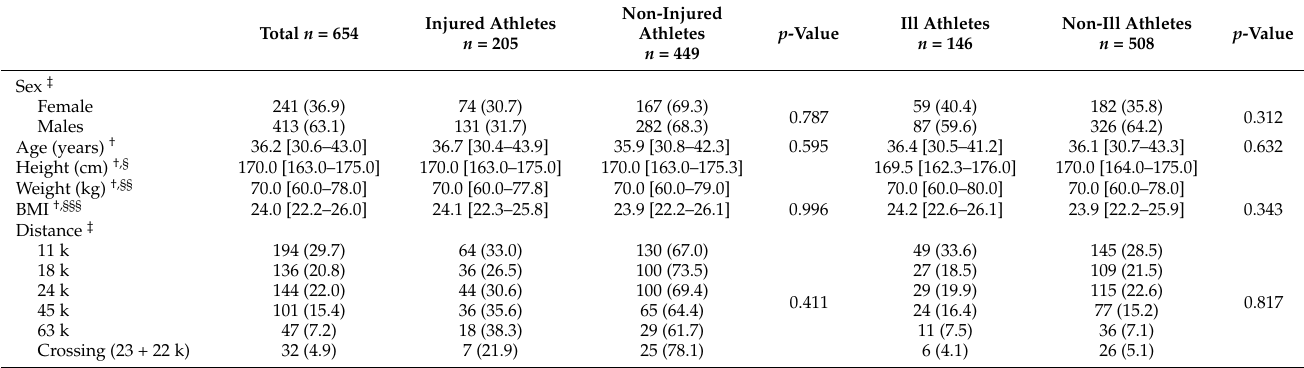
Table 1. Demographic and race distance characteristics of